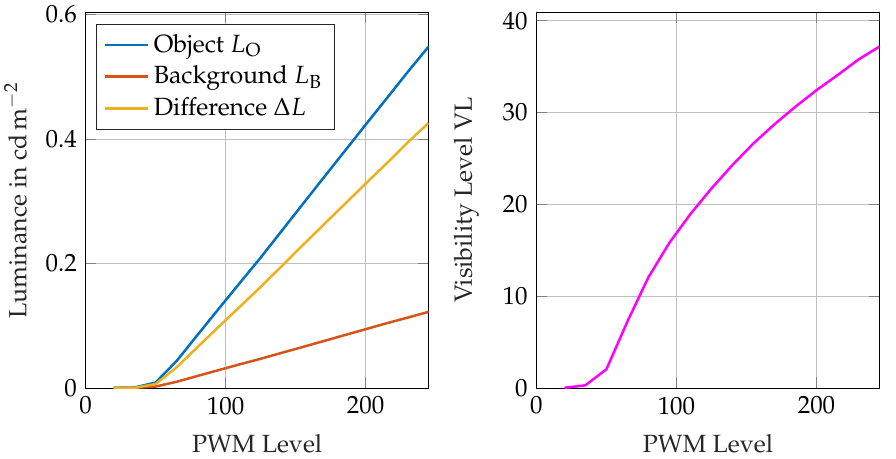
Figure 9. Luminance L ( left ) and Visibility Level VL ( right ) of the gray card at object position 1 in the light tunnel; both luminance and Visibility Level increase with higher PWM